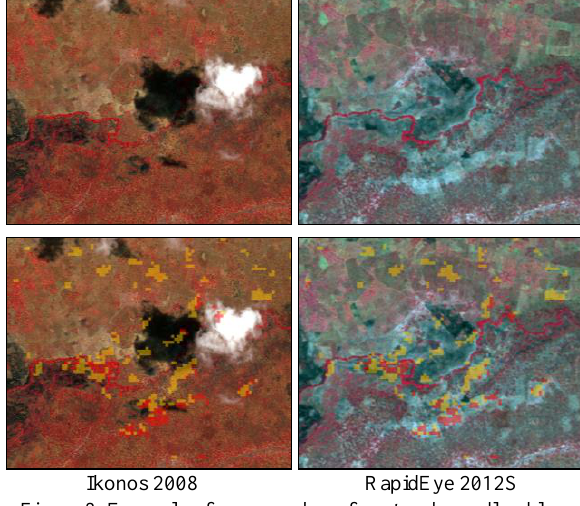
Figure 8. Example of an area where forest and woodland loss was identified. On the left an Ikonos image from 2008, on the right a RapidEye image from 2012. The forest and woodland loss classes (in red and orange, respectively) are overlain on the bottom two